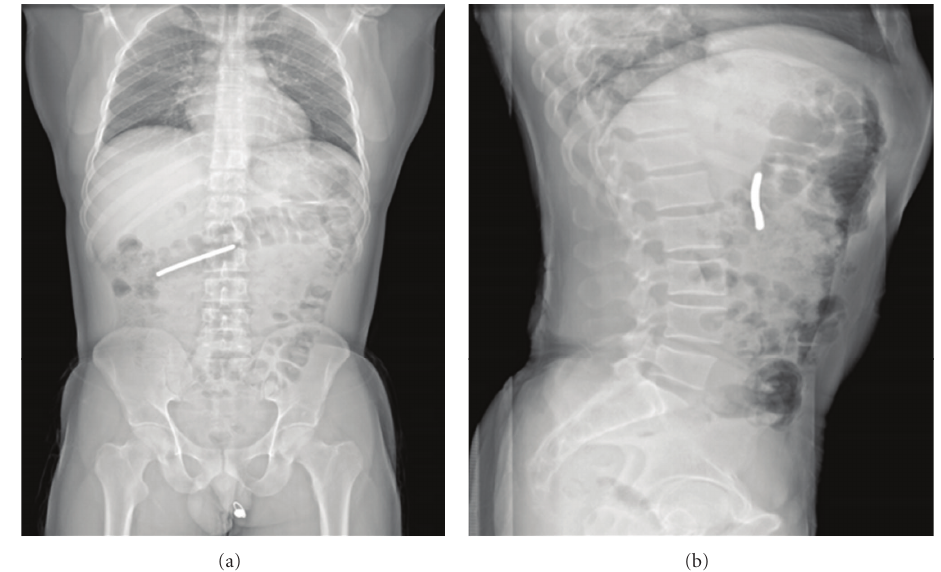
Figure 3: Lodox radiograph showing (a) the AP and (b) the lateral view of an ingested foreign object.